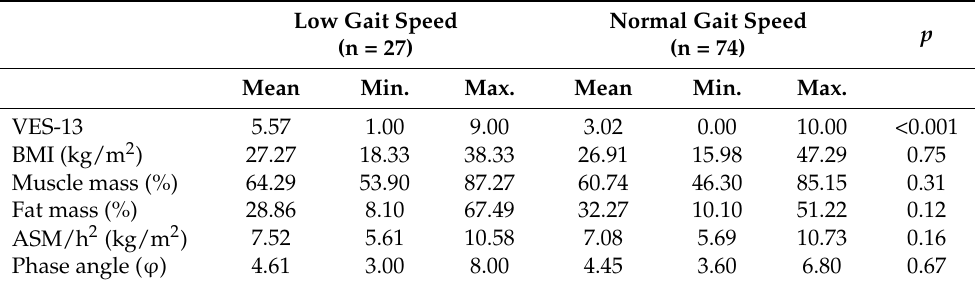
Table 7. Comparison of patients with low gait speed to patients with normal gait speed.